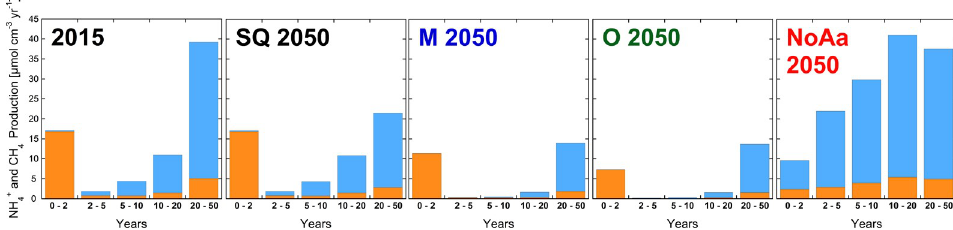
Fig 6. NH 4+ (orange) and CH 4 (blue) production rates (in μ mol cm -3 yr -1 ) at different sediment depths (split up in layers corresponding to different ages since sediment deposition) for the year 2015, and for the year 2050 in the SQ, M, O and the NoAa scenario. Note that as the scenarios have different sedimentation rates, the age of the layers at a certain depth differs between the